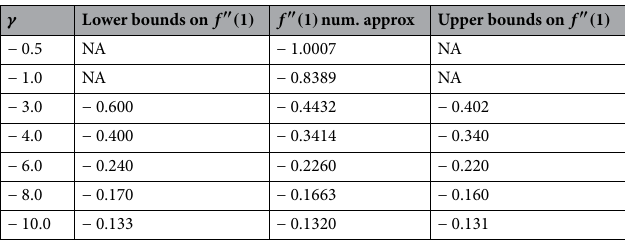
1, M 0.1 and β K p = = =